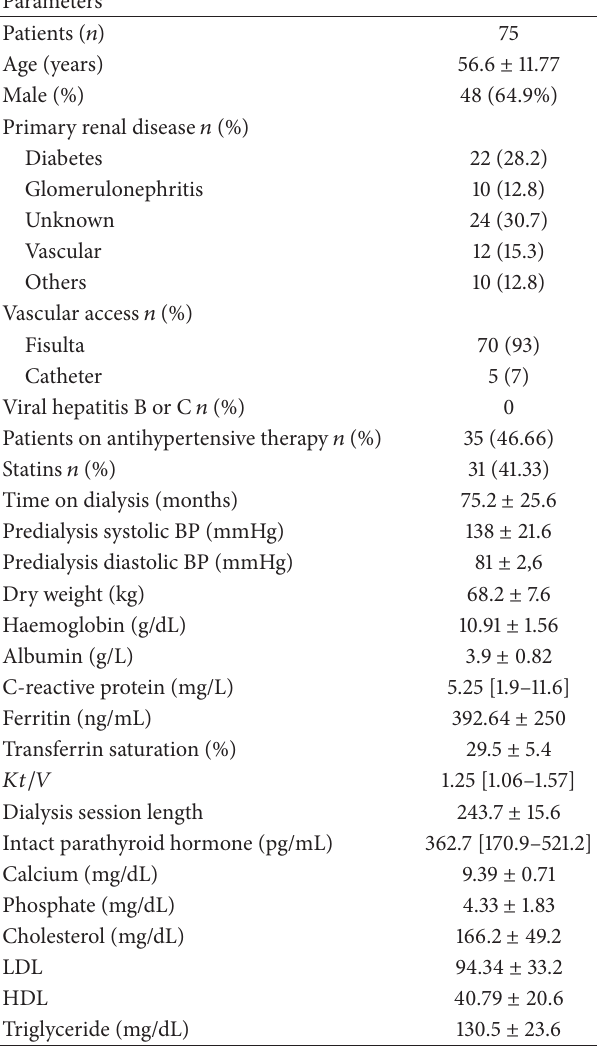
Table 1: Baseline demographic and clinical characteristics of the haemodialysis population.